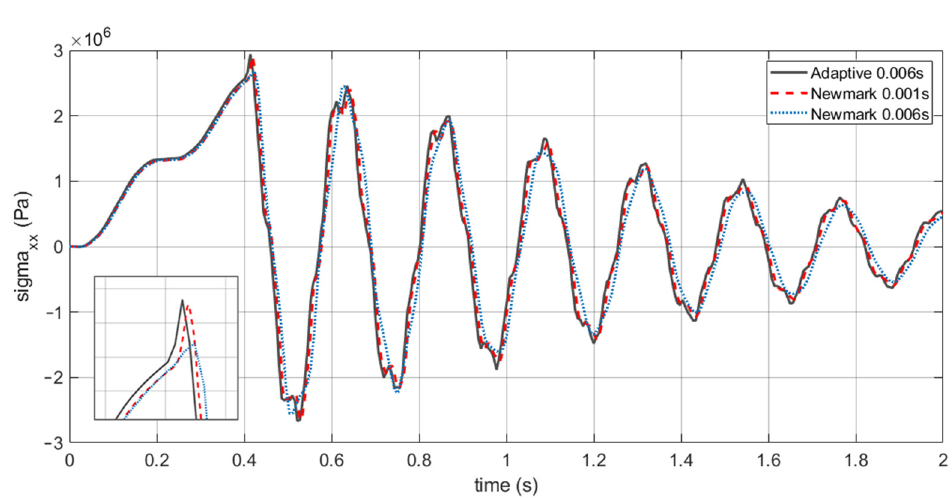
Figure 25. The normal stress σ xx at point C using time-adaptive method and the Newmark method (nonlinear damping c = 1 + t Ns/m ).